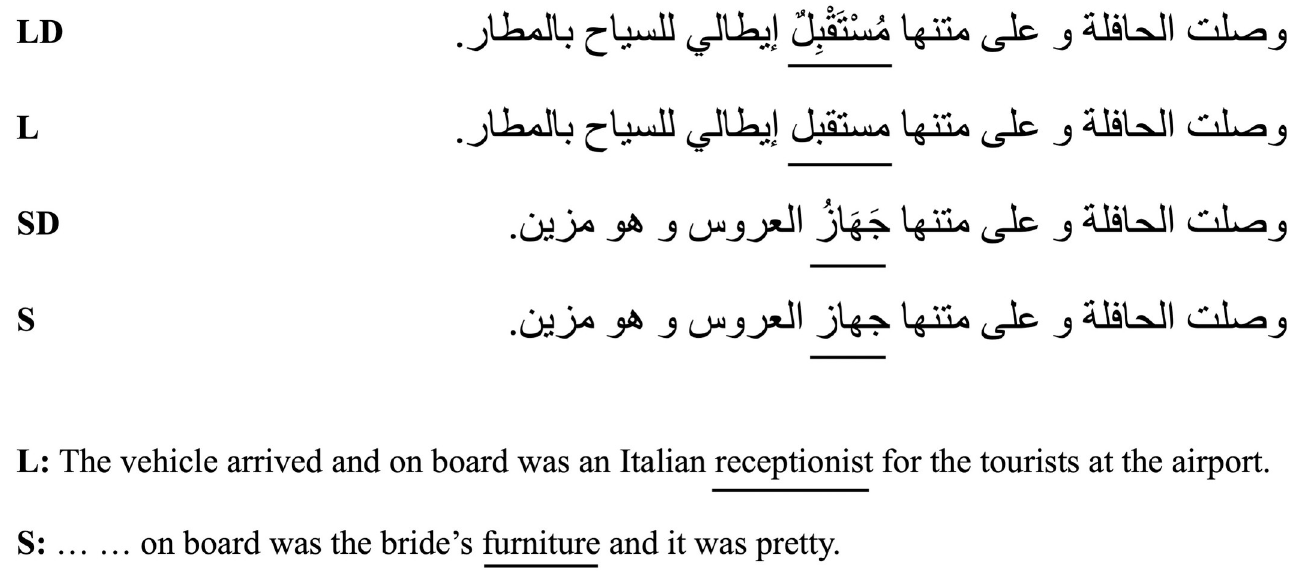
Fig 2. A sample stimuli set for Experiment 2. The target words are underlined in the Arabic frame sentences and the English translation. L and S are long (6 letter) and short (4 letter) target words conditions, respectively, and LD and SD are diacritized long and short target words conditions, respectively.